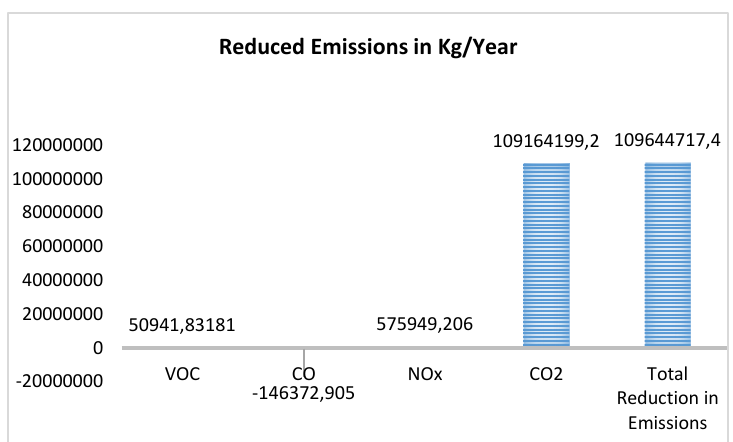
Figure 10: Reduction in Emissions after